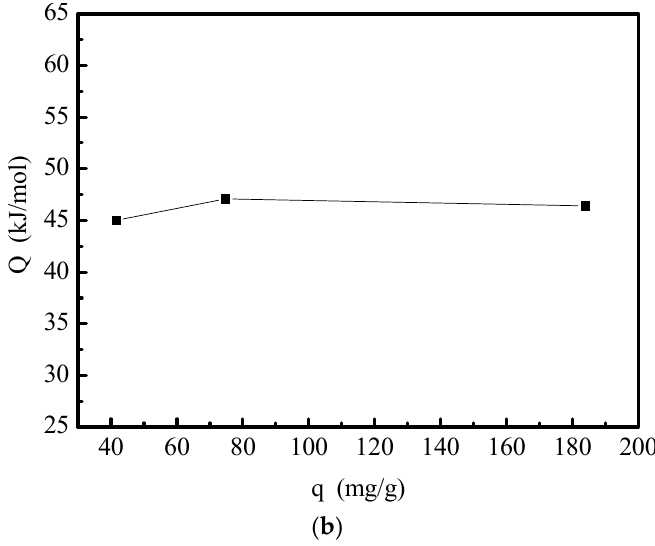
Figure 4. Amount and isosteric heat of water adsorption in the solid amine. ( a ) Isotherm adsorption in the solid amine. ( b ) Heat of water adsorption of the solid amine at 30 °C.